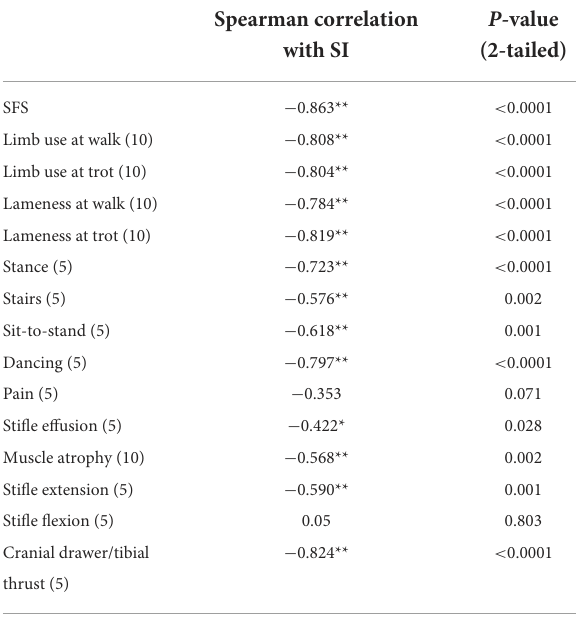
TABLE 1 Spearman correlation between SI and other